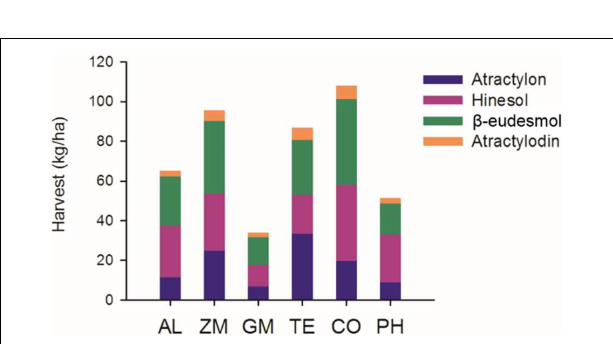
FIGURE 7 | The harvest of total volatile oils from different intercropping treatments in